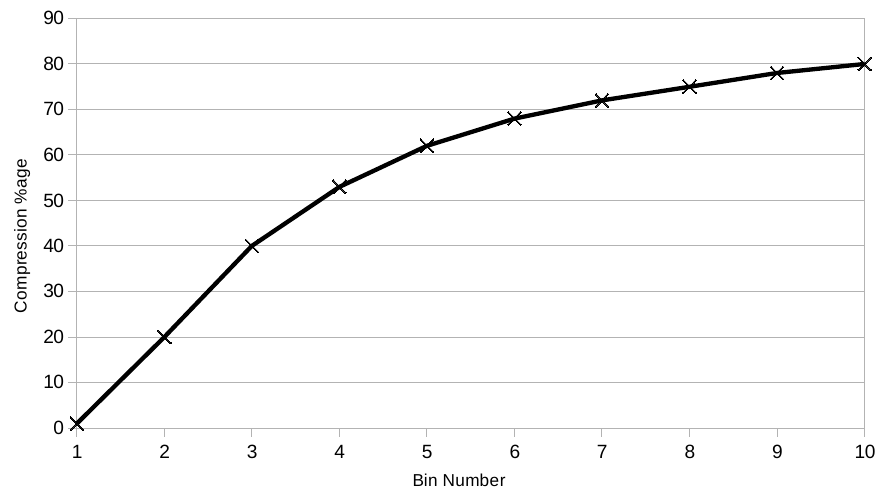
Figure 3. Percentage compression increases with increase in bin number. Higher term counts are being penalized more without affecting their importance.